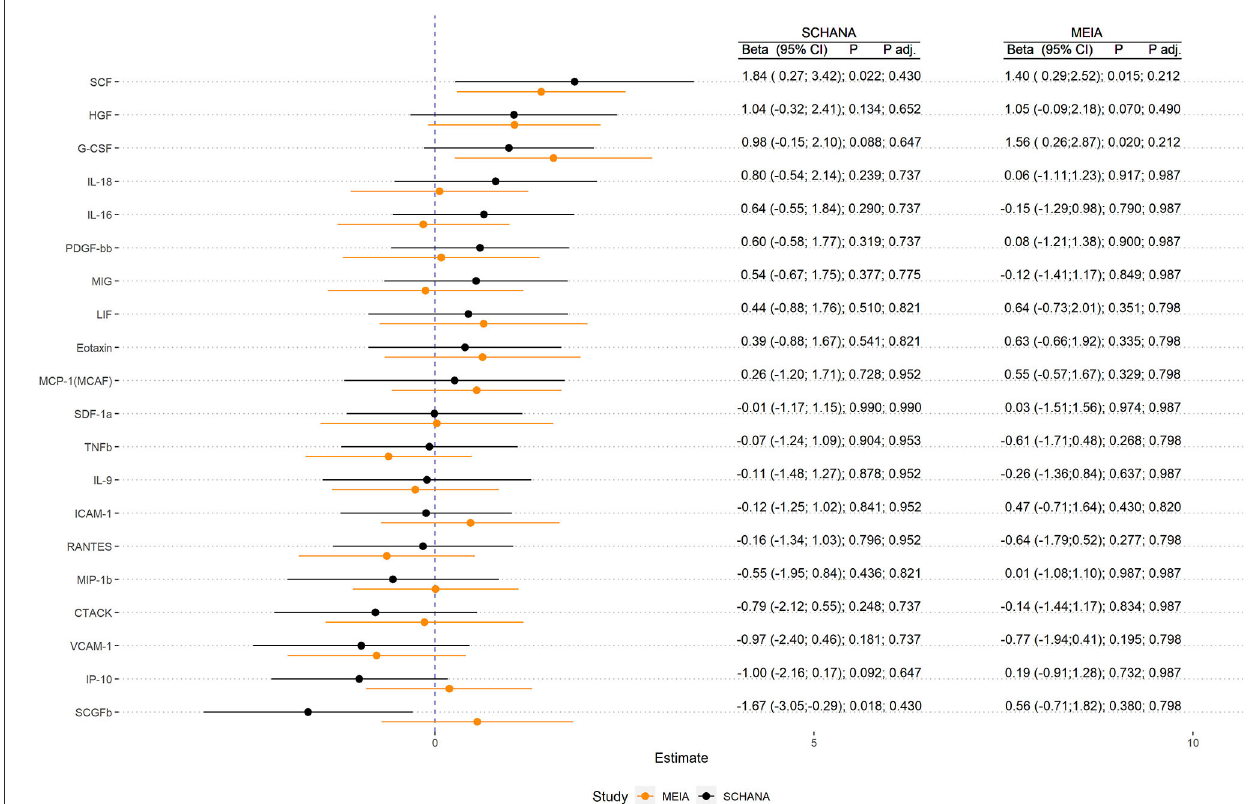
FIGURE1 Association of inflammation markers with fatigue in 327 patients with stroke (SCHANA study) and 140 individuals from the general population (MEIA study).